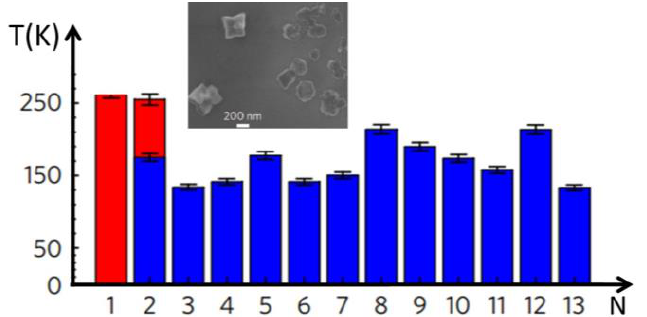
Figure 11. Yb 3+ :YLF crystals (inset) and their internal temperatures for 1031 nm (red) and 1064 nm (blue) trapping wavelengths. N is the particle number.